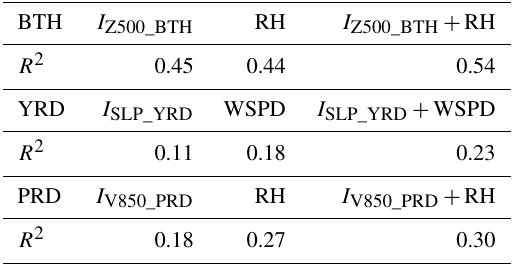
Table 3. Linear relationship (explained variance) of daily PM 2 . 5 concentrations in BTH, YRD and PRD, with the circulation-based index of Table 2, the most important regional meteorological field in each region and the linear combination of both during DJF 2013– 2017. All the linear relationships are significant at the 99% confi- dence